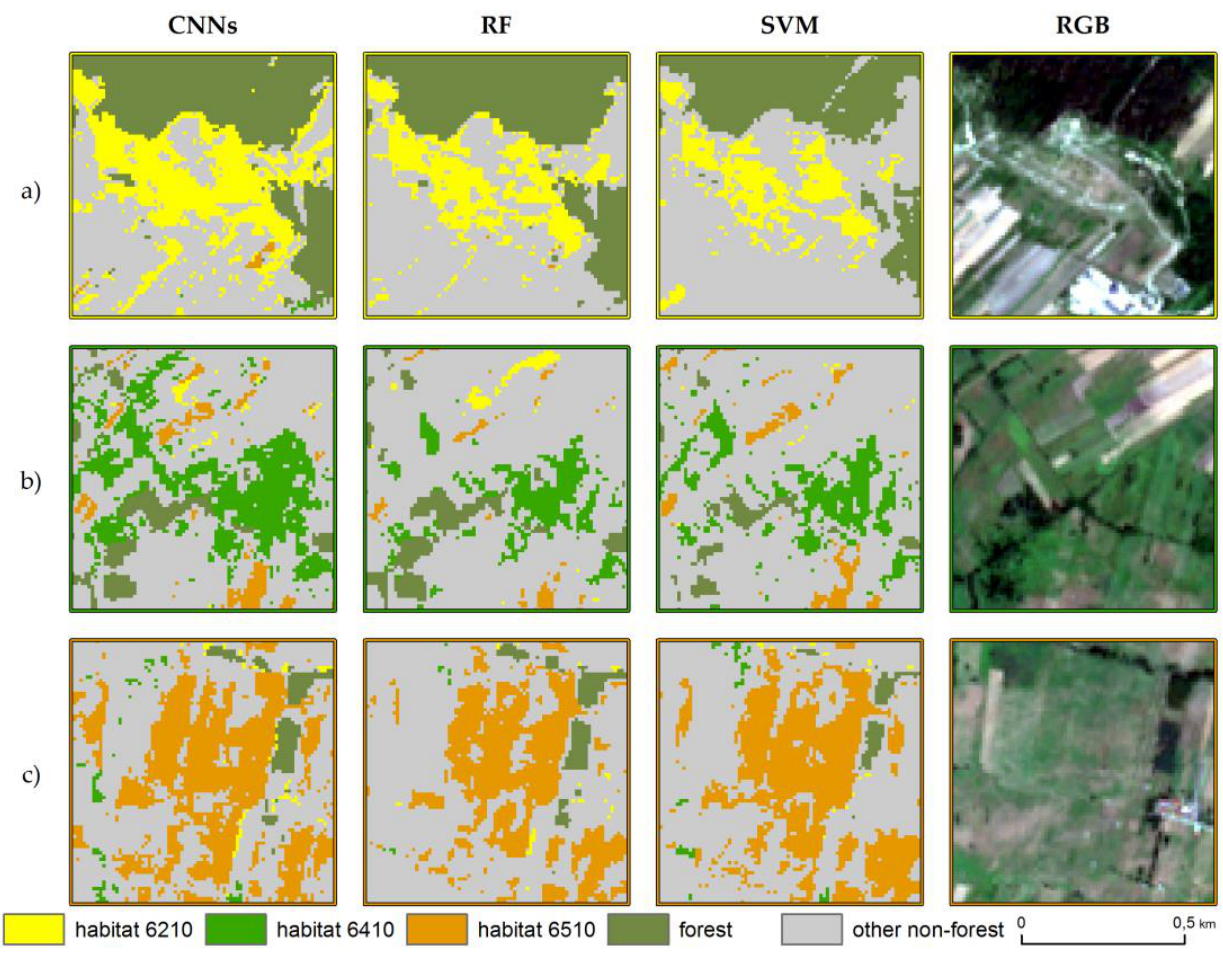
Figure 6. Parts of the maps produced with different algorithms, presenting examples of the larger share of the area occupied by each habitat: ( a ) 6210, ( b ) 6410, ( c ) 6510. In general, using the proposed methods, we were able to obtain high OAs (median values from the 100-fold accuracy assessment were higher than 0.84; Figure 7). Comparing the algorithms’ performances, the best OAs were reached for SVM (median value around 0.88), and the worst were for CNNs (0.84). As can be noticed, differences between median values did not exceed 4 percentage points (p.p.). Moreover, the minimum and maximum noted values were rather small (5 p.p. and 3 p.p., respectively). The values for RF and SVM were more stable, giving a difference between the minimum and maximum values of 4